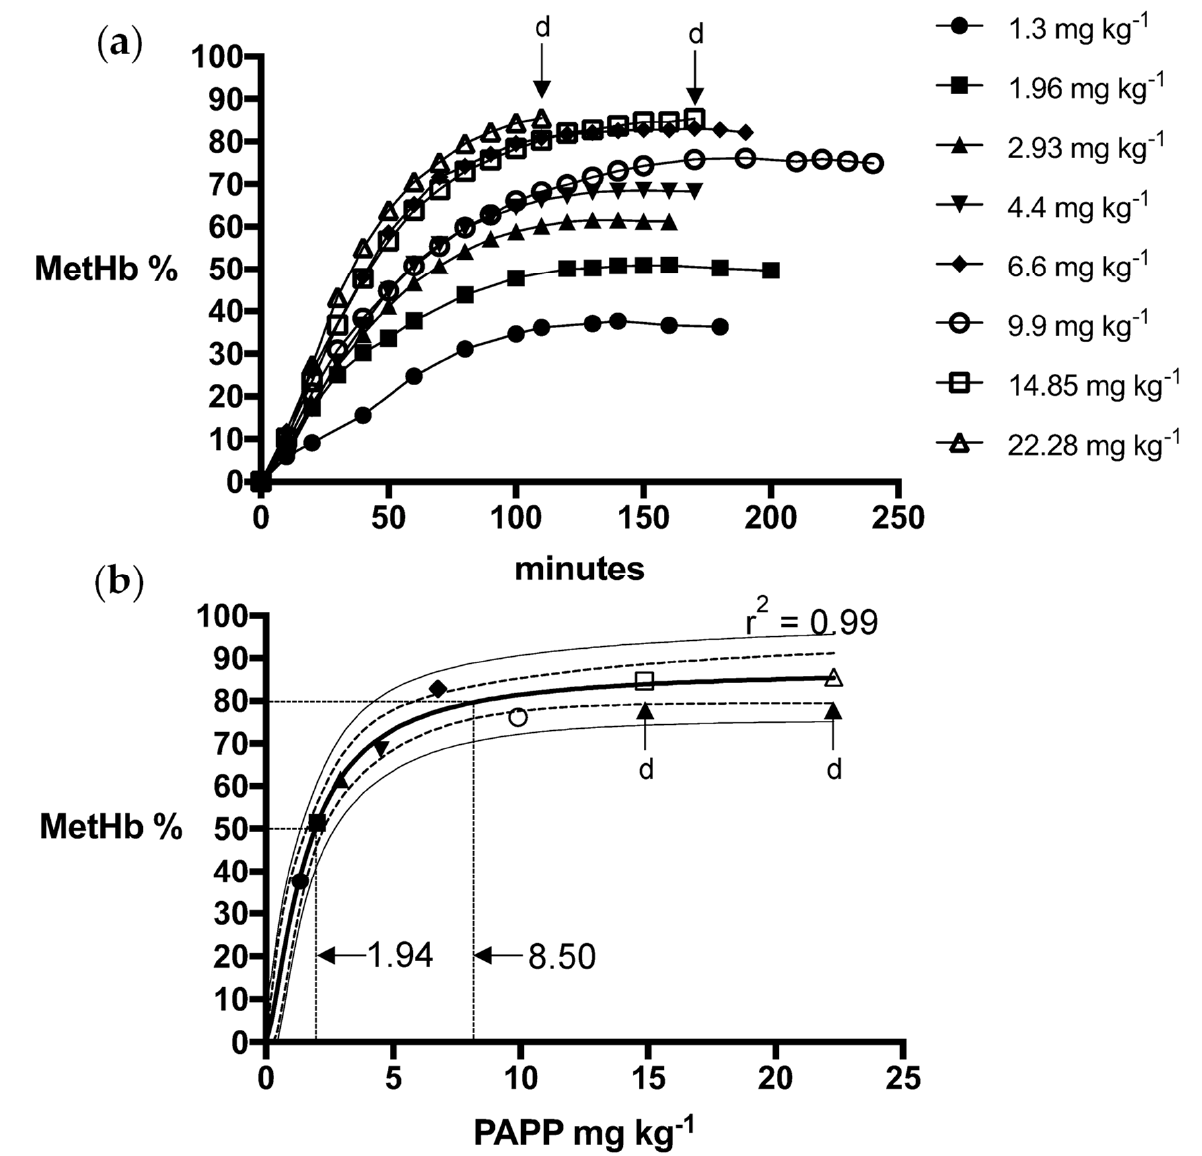
Figure 2. ( a ) Methaemoglobin (MetHb %) response relative to oral dose of PAPP in DMSO in wild dogs and ( b ) the fitted logistics dose-response model for peak MetHb % with 95% confidence (dashed line) and prediction interval (solid line) and whether death (d) resulted.